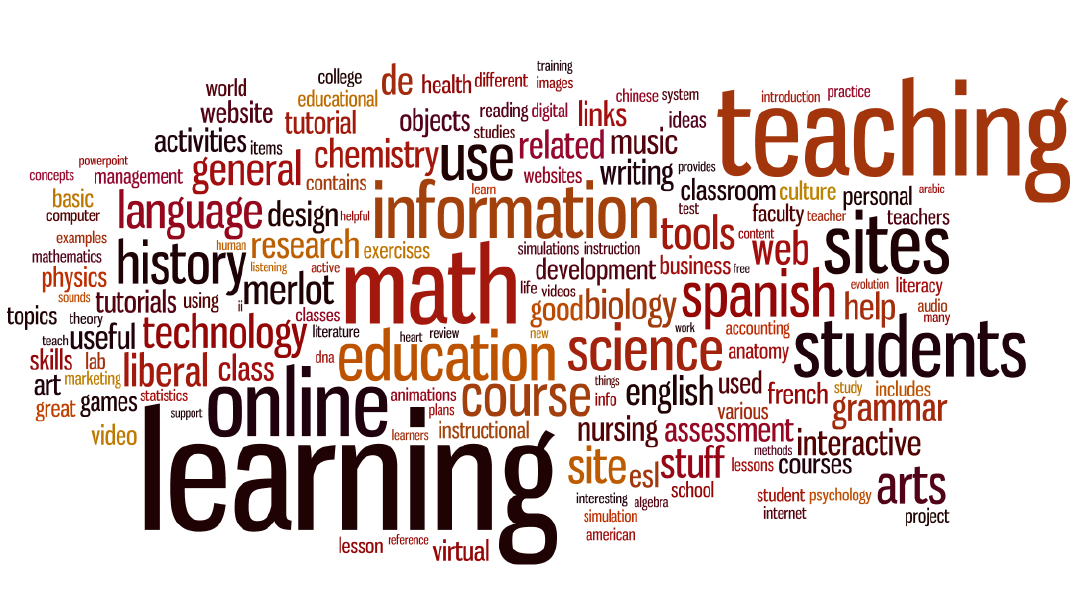
Figure 1. Word Cloud of Bookmark Collections text The collection number grows over time as well as the number of members creating them (Figure 2). During the past eight years, the number of collections increased from 7,837 to 20,138, and the number of collection creators increased, as well, from 4,330 to 9,802.